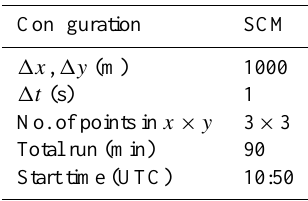
Table 2. LES model configuration. Table 3. SCM model